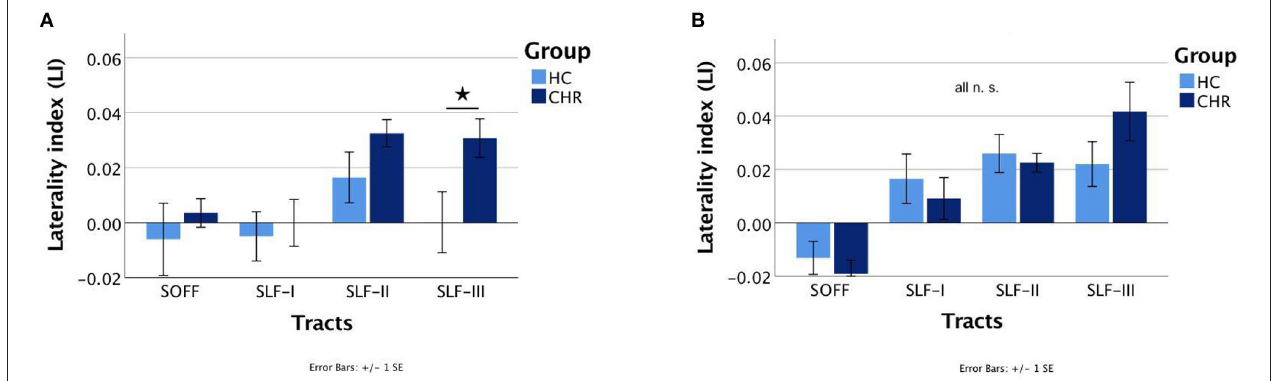
FIGURE 2 | Mean laterality indices of the superior occipitofrontal fasciculi (SOFF) and the superior longitudinal fasciculi (SLF) I, II, and III for healthy controls (HC) and individuals at clinical high-risk (CHR). The significant different laterality index of the SLF-III between HC and CHR females is marked with an asterisk. (A) Females and (B) Males. N.S., not significant.